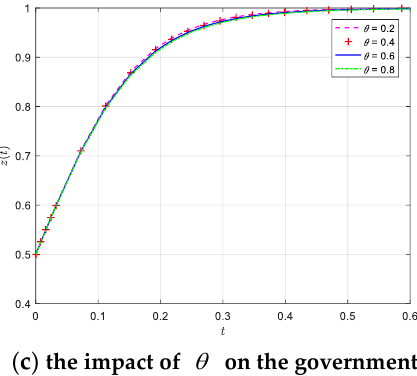
Figure 9. The impact of different loan probability coefficients θ on the enterprise, service provider, and government.